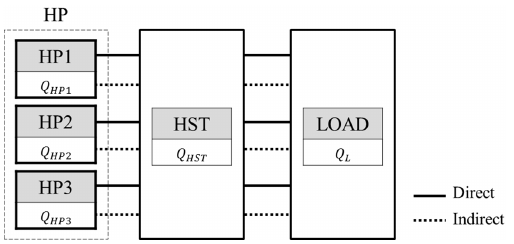
Figure 4. Conceptual diagram of system configuration. HP: Heat pump; HST: Heat storage tank.